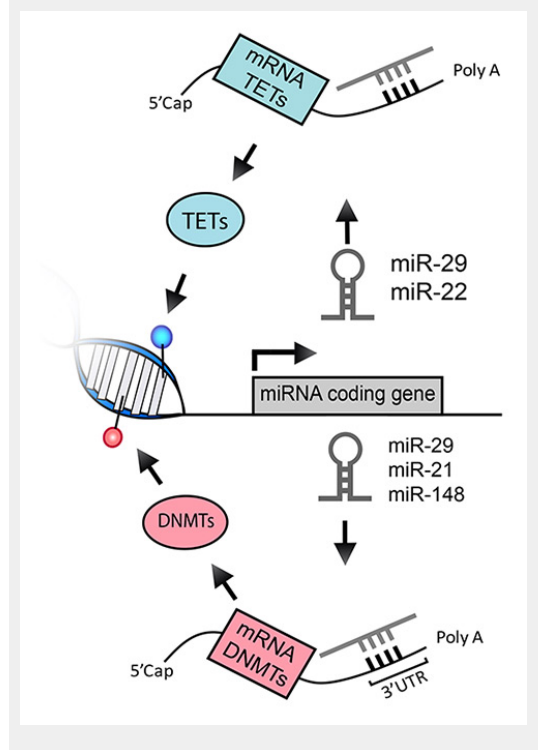
Figure 3 Interplay between miRNAs and the DNA methylation machineries. MiRNAs are both target and effector of epigenetic modifications. Expression of miRNAs can be modulated by levels of DNA methylation in the gene locus of any given miRNA. In turn, mature miRNAs bind the 3’UTR of target mRNAs leading to a reduction in protein output. DNMT and TET mRNAs can be targeted by miRNAs such as miR-29, miR-22 and others, thereby modulating the levels of DNA methylation and hydroxymethylation. DNMT = DNA methyltransferase; miRNA = micro RNA; mRNA = messenger RNA; TET = ten-eleven translocation protein; UTR = untranslated region